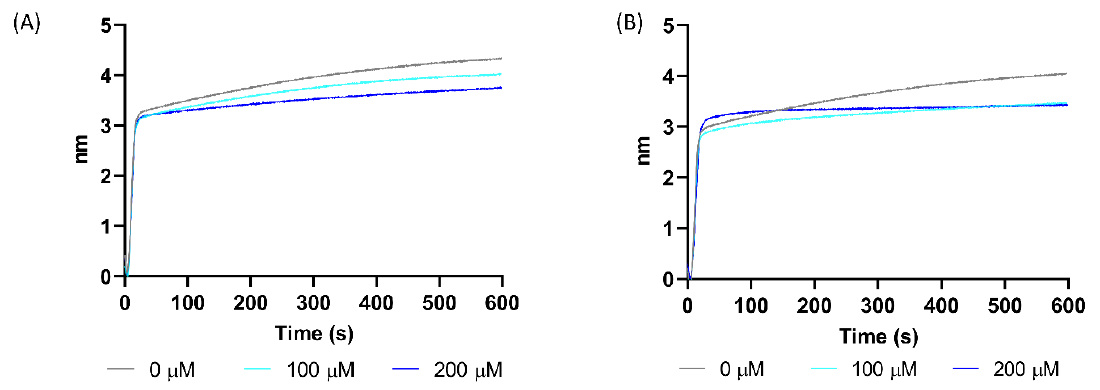
Figure 6. 70812 disrupts DNA binding to N-Myc-Max DBD. ( A ) Inhibition of Myc-Max interaction by 70551 with biotinylated E-box was quantified by bilayer interferometry (BLI) at concentrations of 0 µ M, 100 µ M, and 200 µ M. ( B ) 70812 could disrupt DNA from binding to the N-Myc-Max DBD at concentrations of 100 µ M and 200 µ M in BLI assays. The experiments are representative of 3 biological replicates.